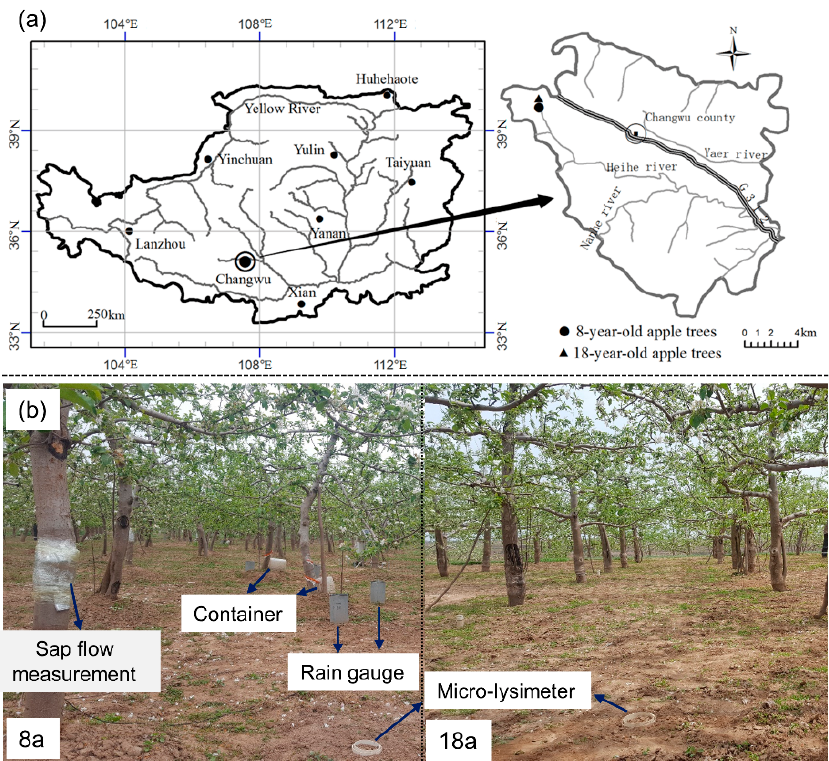
Figure 1. Locations of the 8- and 18-year-old orchards (8a and 18a, respectively) in the Wangdonggou watershed ( a ) and facilities for measuring the components of evapotranspiration in the orchards ( b ).